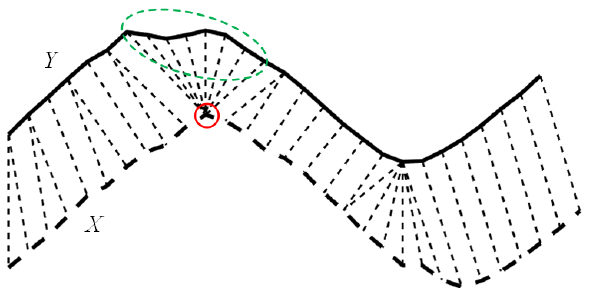
Figure 1. Demonstration of the pathological alignment problem of DTW, where one node in X (marked with the red solid circle) is matched with too many nodes in Y (marked within the green dotted circle).